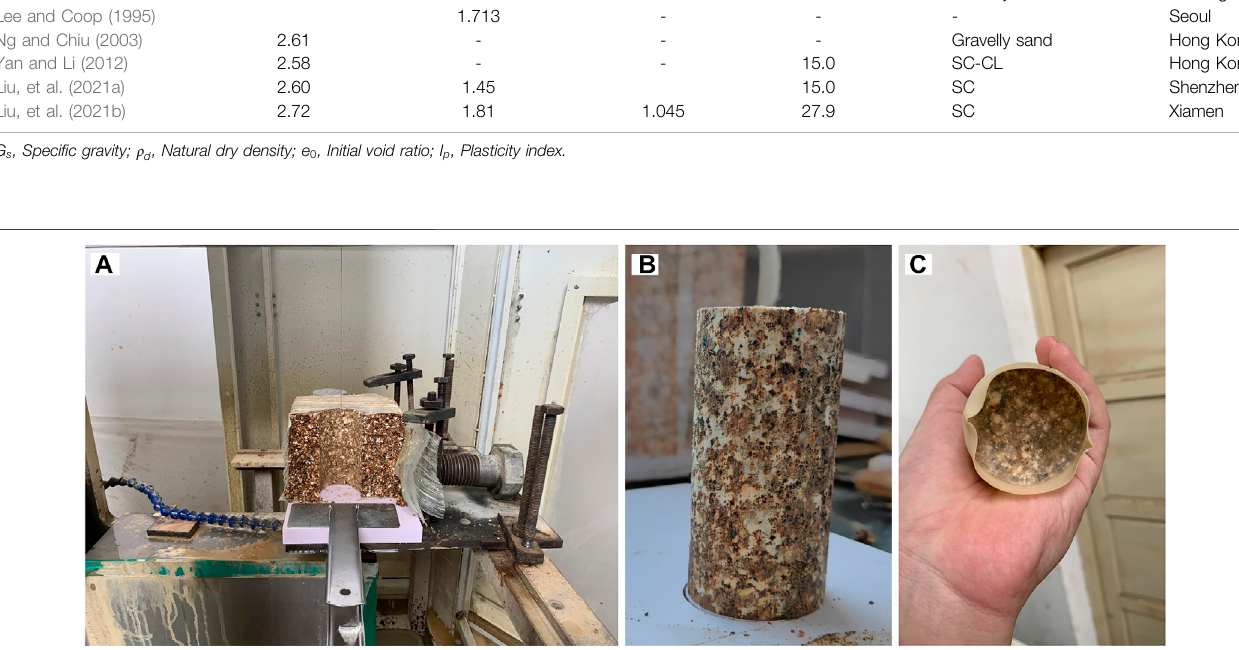
Frontiers in Earth Science |